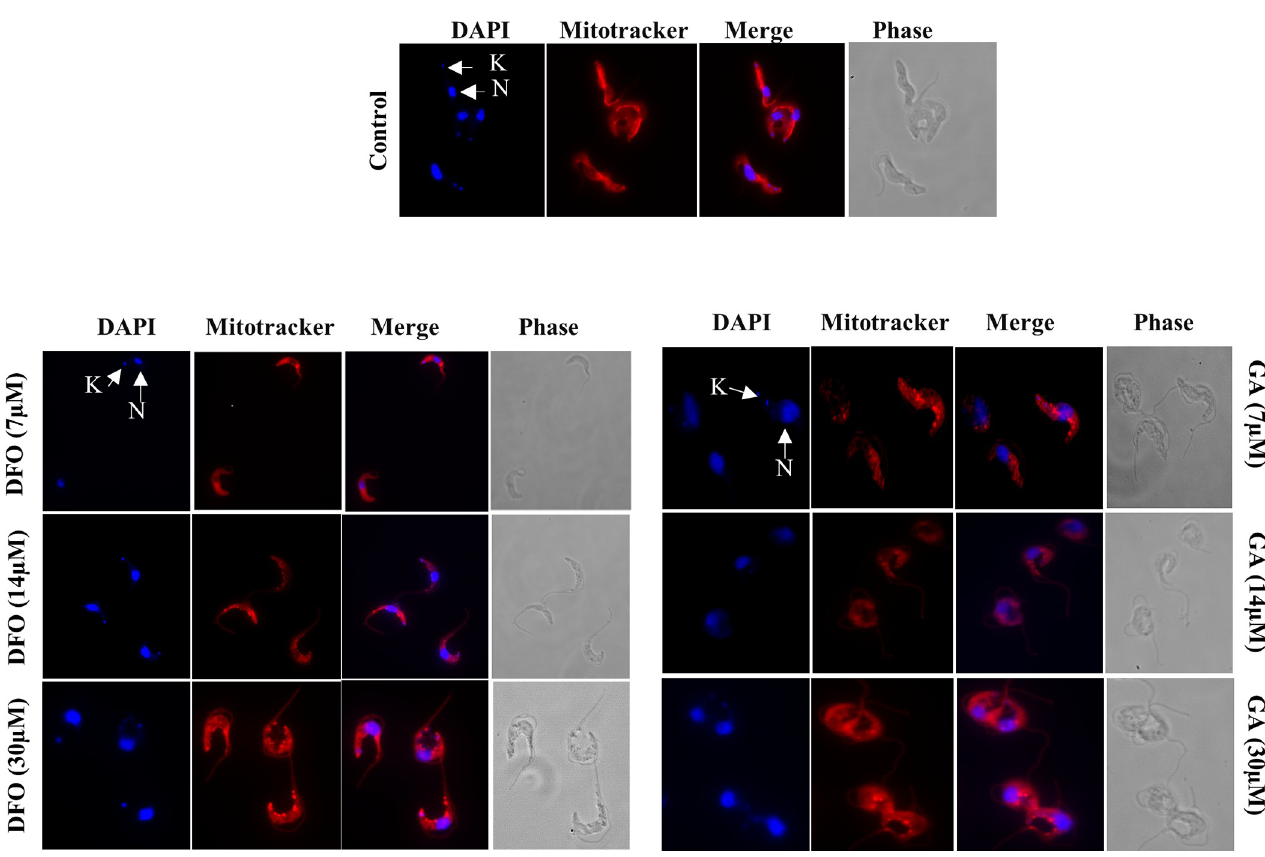
Fig 5. Effect of deferoxamine and gallic acid on the mitochondrial membrane integrity and T . b . brucei morphology. Trypanosomes were treated with deferoxamine (DFO and GA) [7 μ M; 14 μ M; 30 μ M] labeled for mitochondria with Mitotracker red dye (red), counterstained with DAPI for DNA (blue) and cell morphology visualized using the fluorescent microscope (100x). The concentrations used were 2x IC 50 , 4x IC 50 , 9x IC 50. and ½ IC 50 , IC 50 and 4x IC 50 for DFO and GA respectively. The control samples used here are the same as those in Fig 4 (All the microscopy experiments were done in